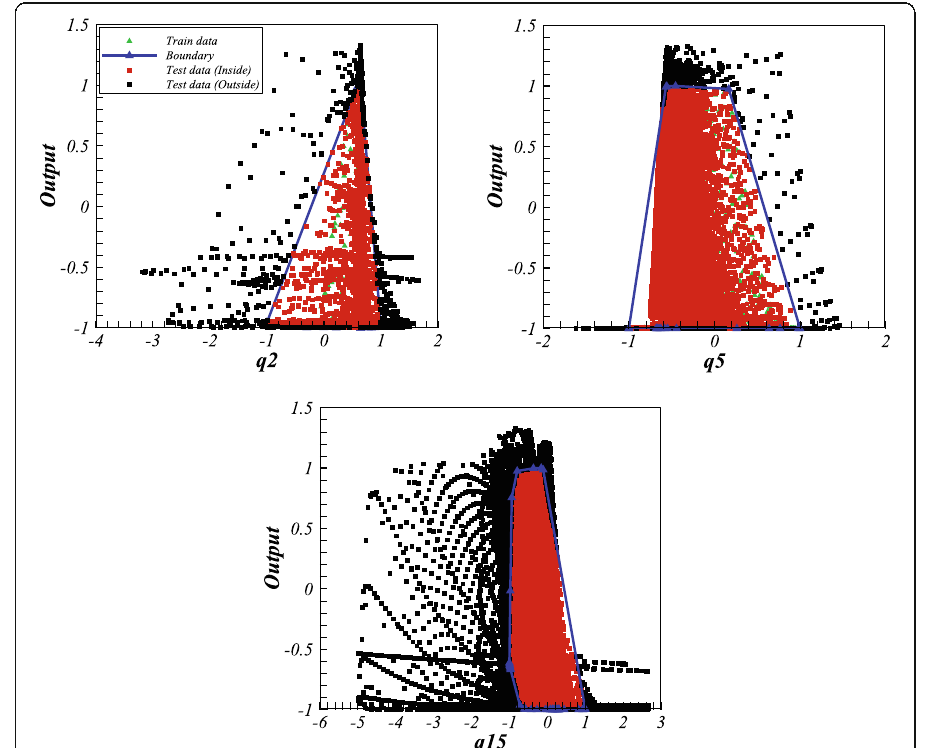
Fig. 6 The numerical distribution of some features of dataset D and